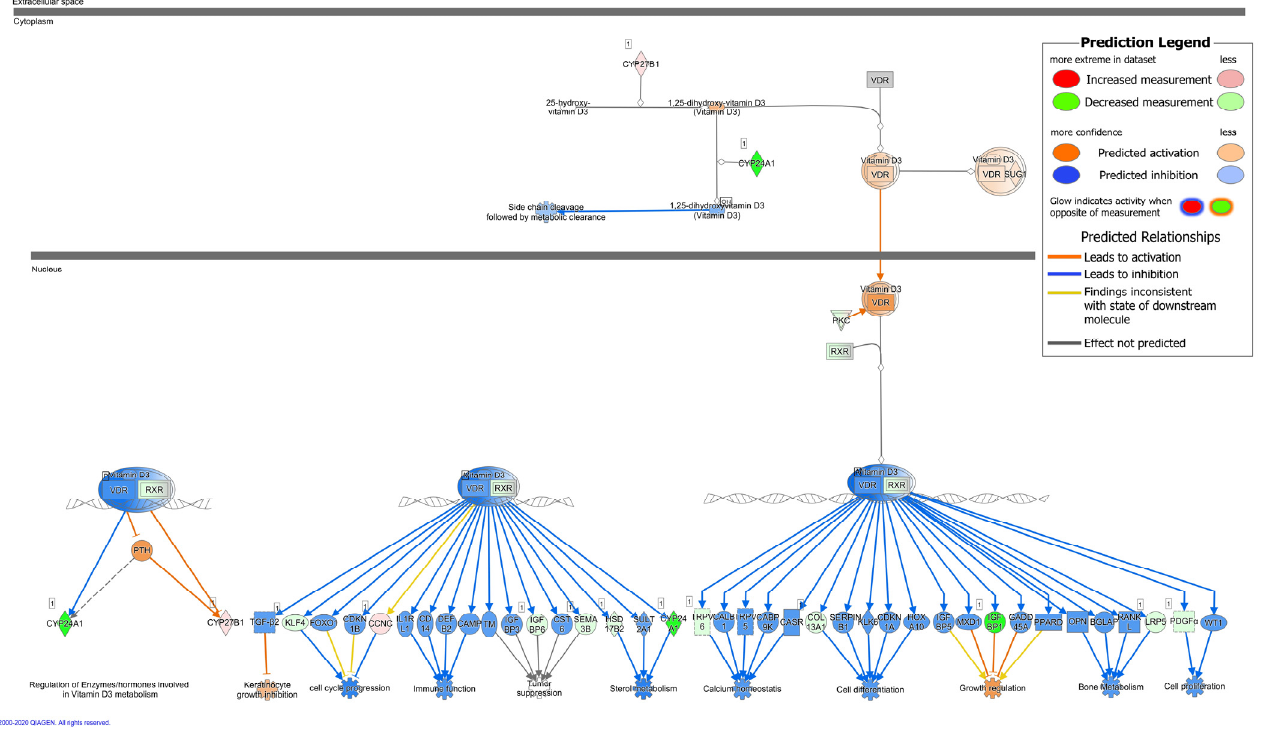
Figure 1. Ingenuity Pathway Analysis (IPA) of RNA-Seq data showing VDR/RXR activation in colonic mucosae from C. jejuni -infected patients. CYP27B1 activates 25-hydroxy vitamin D3 (calcidiol) to biologically active 1,25-dihydroxy-vitamin D3 (calcitriol). CYP24A1 inactivates vitamin D and therefore opposes the action of CYP27B1. Active vitamin D binds to the VD receptor (VDR), enters the nucleus, forms a complex with the retinoid X receptor (RXR), and influences the expression of different target genes. Blue arrows indicate predicted inhibition and orange arrows predict activation of the network components. A colored legend is shown in the upper right corner of the figure.